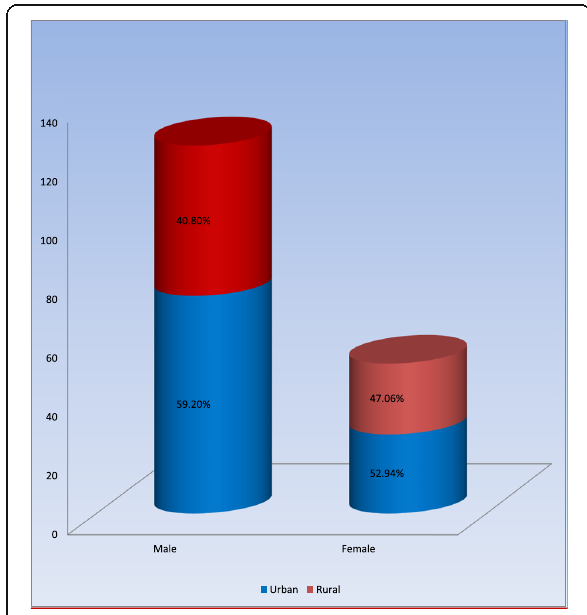
Fig. 3 Distribution of drowning deaths as per region of occurrence